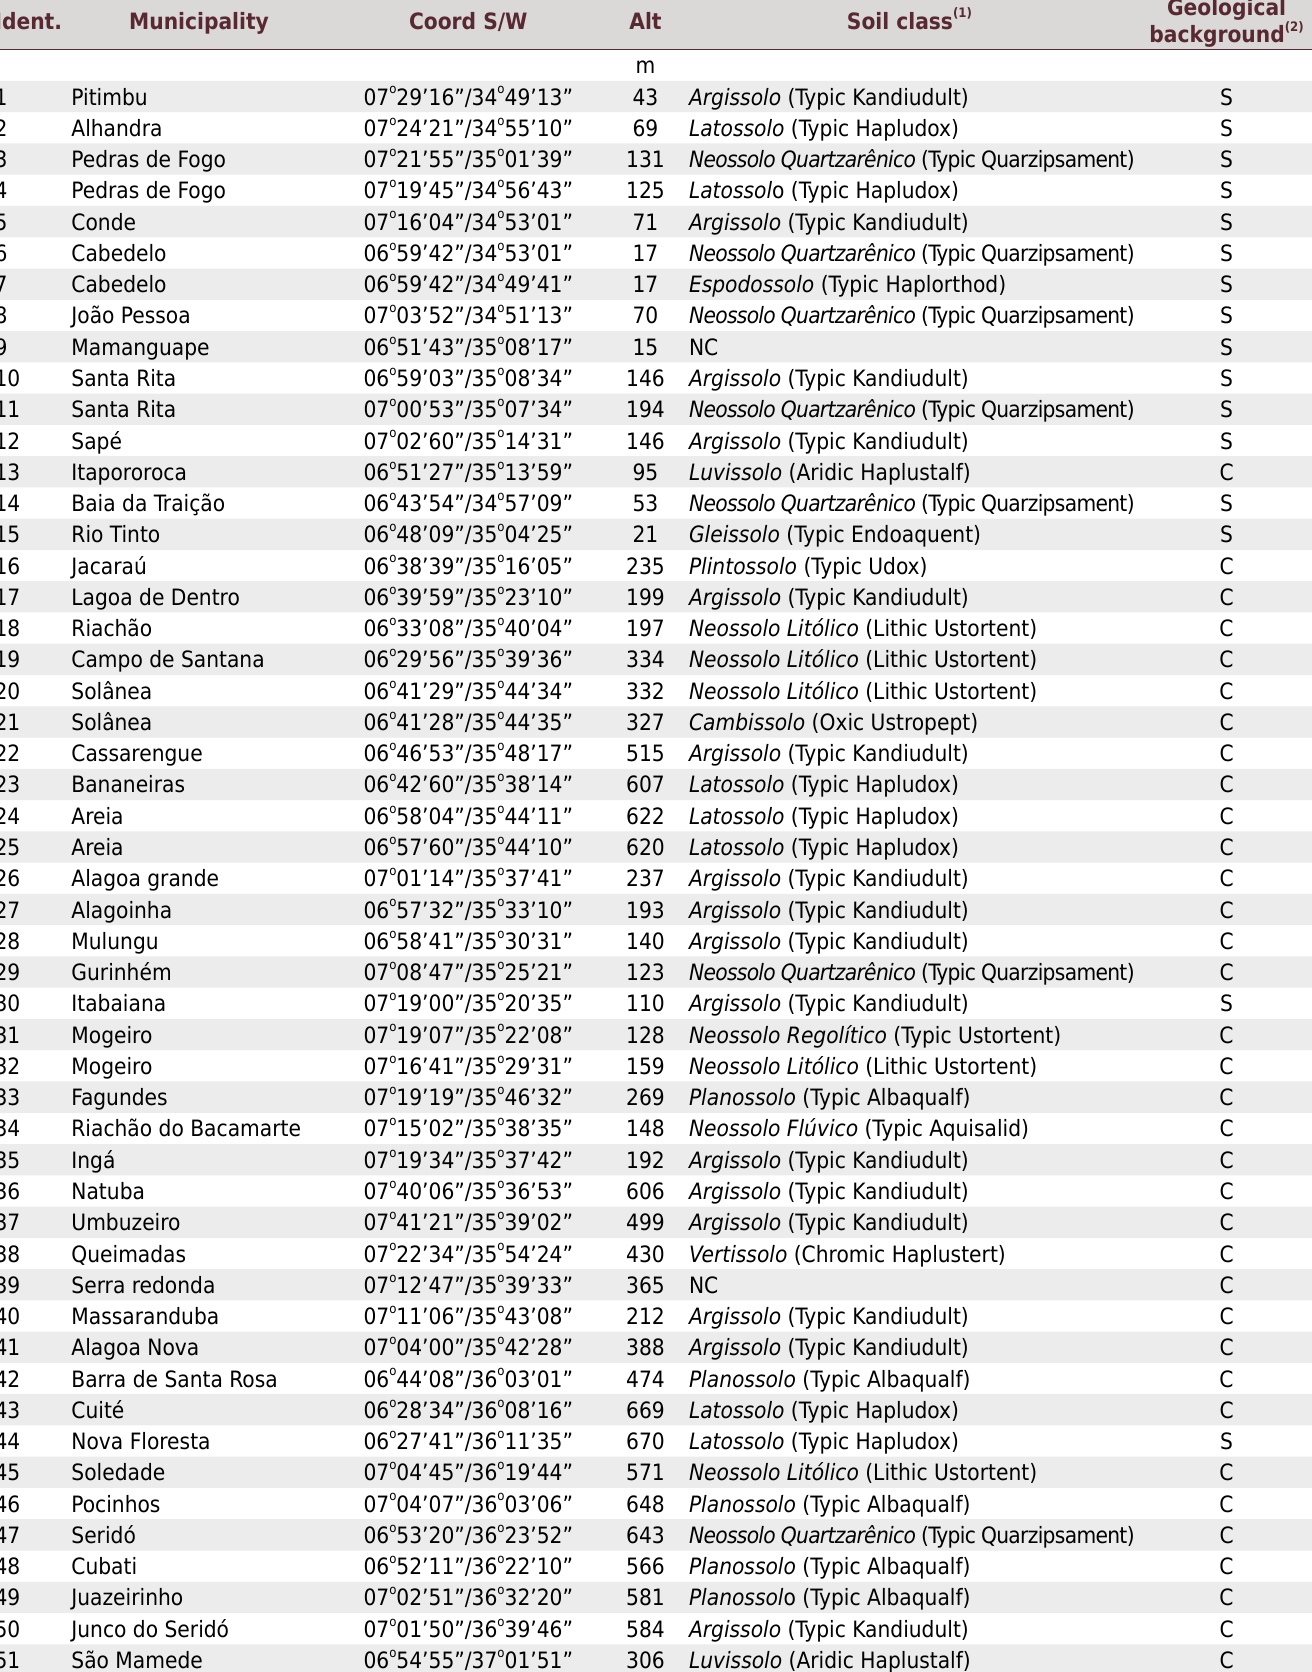
Table 1. Identification, sampling locations (municipalities), geographical coordinates (Coord S/W), altitude (Alt), soil classes, and geological background of the studied soil